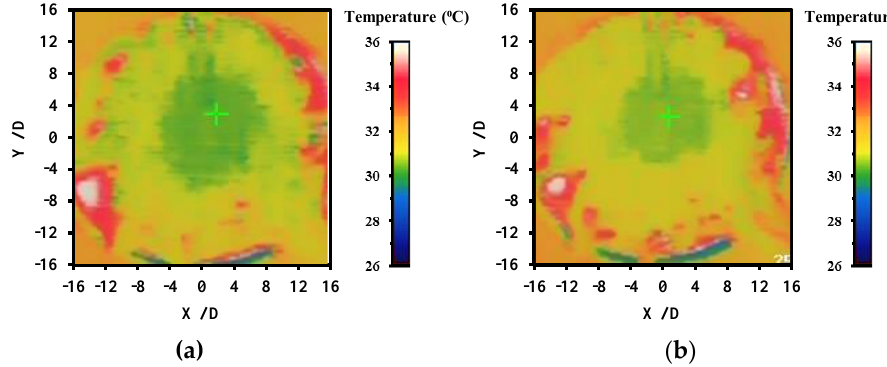
Figure 14. Result of Nusselt number vs. Reynold number for hybrid nanofluid, mono-nanofluids, and base fluids under CIJ and SIJ.